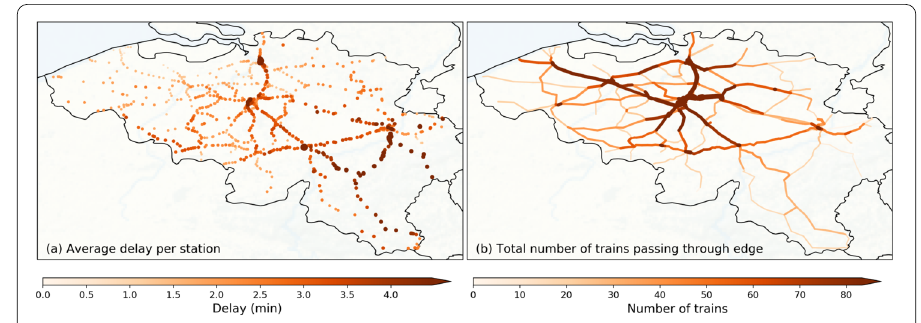
Figure 2 Panel ( a ): Average delay per train in November 2019, shown at every node. Panel ( b ): Average number of trains passed through the edge on April 11th, 2019 (taken as an example day). Only passenger trains are used when calculating these